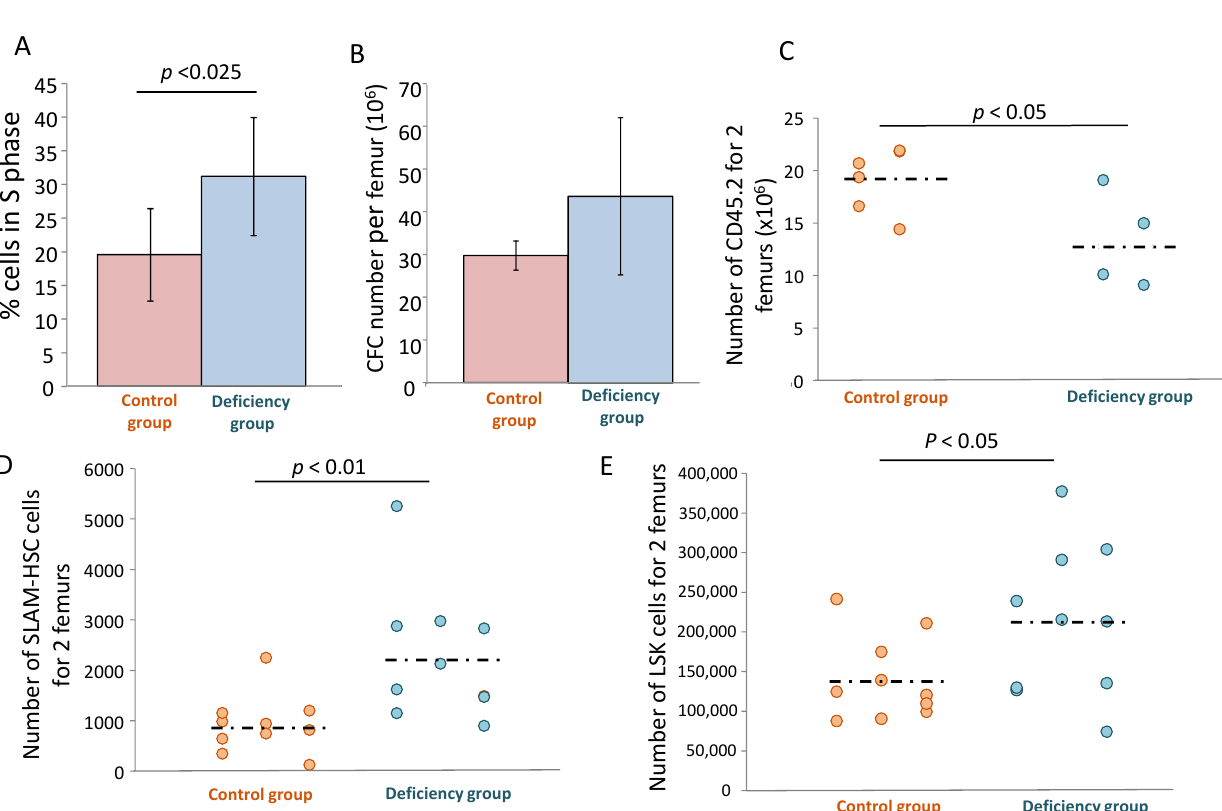
Figure 7. In vivo effect of αTOC on HSC and HPC. In vivo deficiency of αTOC occurring for 2 months increases the fraction of CFC in the S phase of the cell cycle (Ara-C suicide technique) i.e., it promotes the proliferation of HPCs (mean +/− SD) ( A ) and exhibits an increasing trend in the number of committed progenitors per femur (mean +/− SD) ( B ). In vivo αTOC deficiency decreases the bone marrow repopulating ability ( C ) and results in an inflation in the LSK ( D ) and SLAM cell compartments ( E ). CFC = Colony Forming Cells; HSC = Hematopoietic Stem Cells; SLAM = Cells expressing signaling lymphocytic activation molecule family receptors; LSK = Linage negative, Stem cell antigen (Sca-1) positive, C-kit positive.